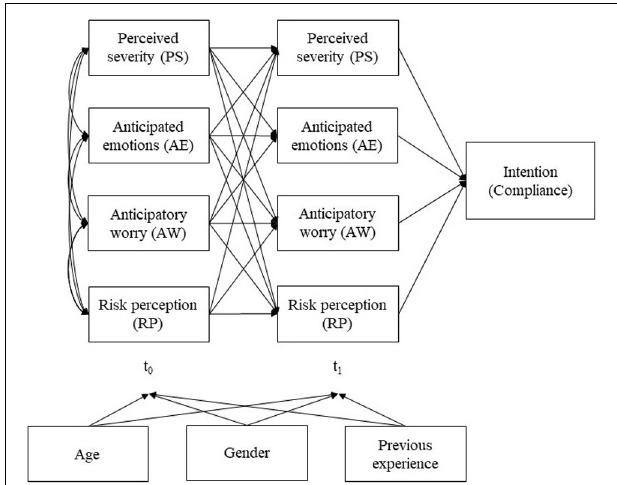
FIGURE 1 | Simplified path model. Four components of risk appraisal (PS, AE, AW, RP) before ( t 0 ) and after ( t 1 ) the receipt of a warning message regarding one of three hazard types (severe weather, violent act, or the COVID-19